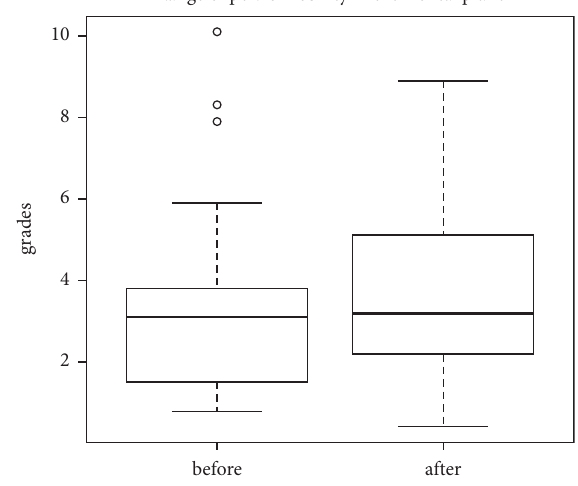
Figure 13: Distribution of the pelvic range of motion relative to the lumbar region during